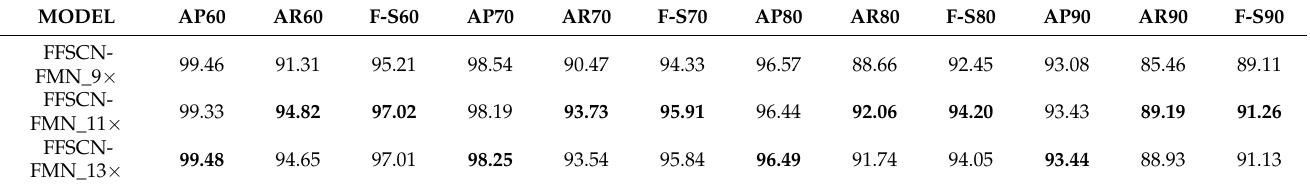
Table 5. Performance comparison of different downsample times used in the FFSCN-FMN model. MODEL